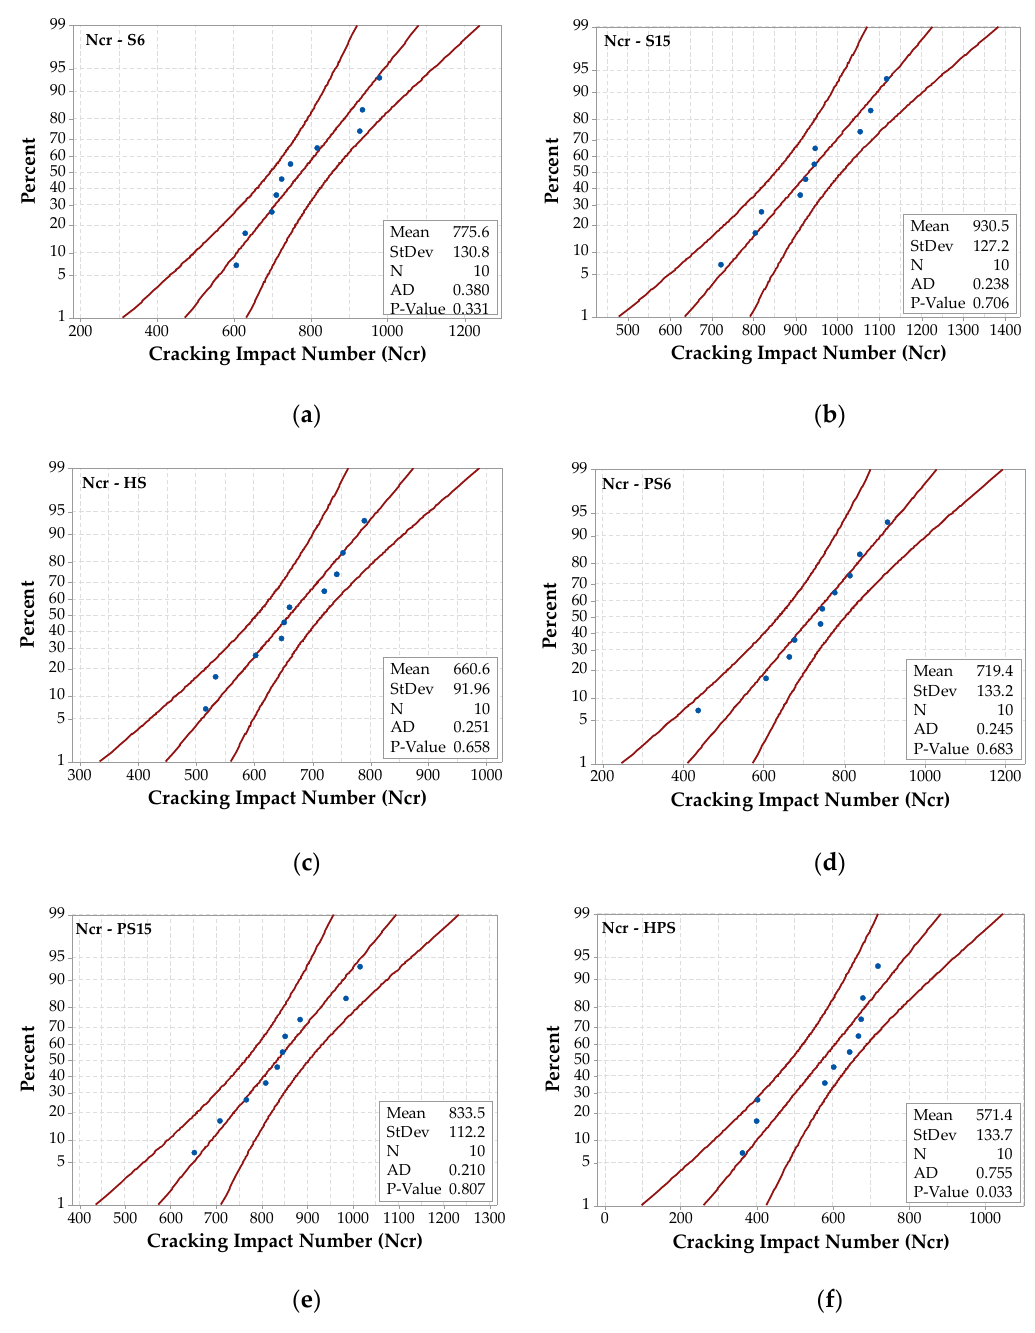
Figure 10. Normal probability plots of the cracking impact number Ncr. ( a ) S6; ( b ) S15; ( c ) HS; ( d ) PS6; ( e ) PS15; ( f ) HPS.